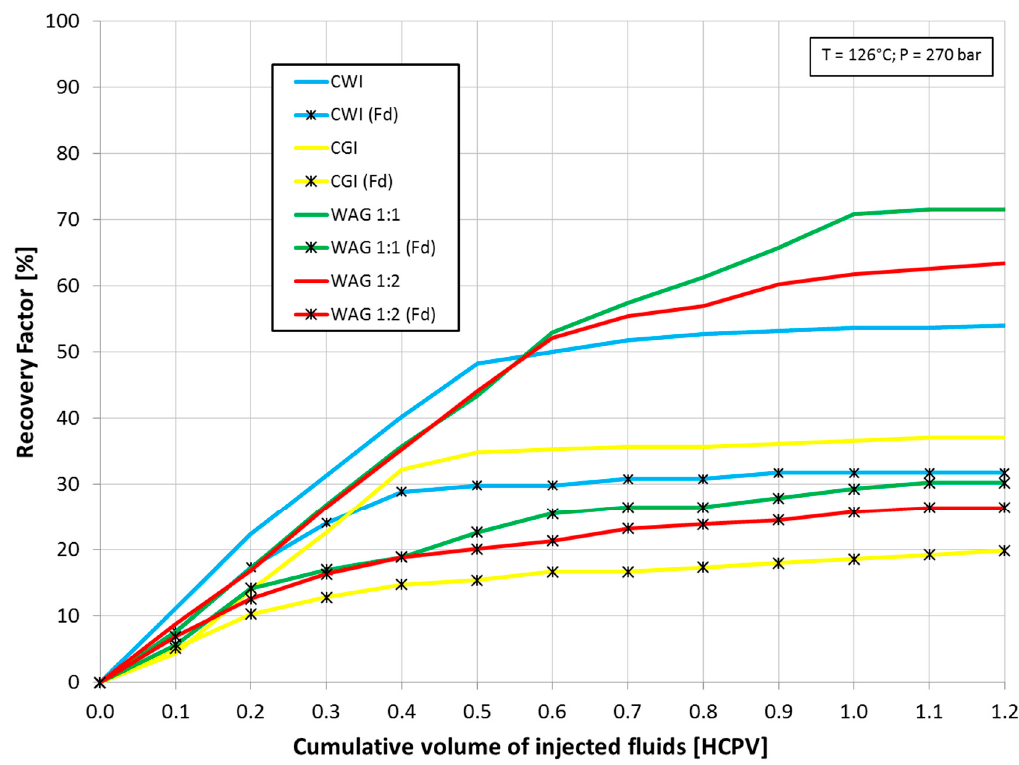
Figure 7. Comparison of oil recovery e ffi ciency in non-fractured and fractured (Fd) cores.